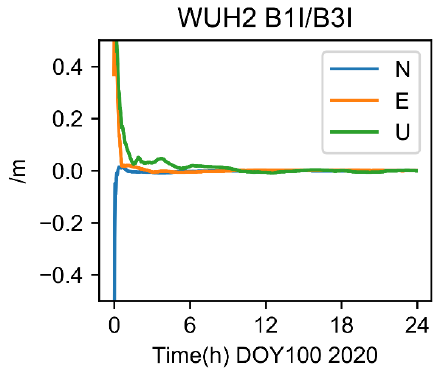
Figure 5. BDS B1I/B3I ionosphere-free results of WUH2.